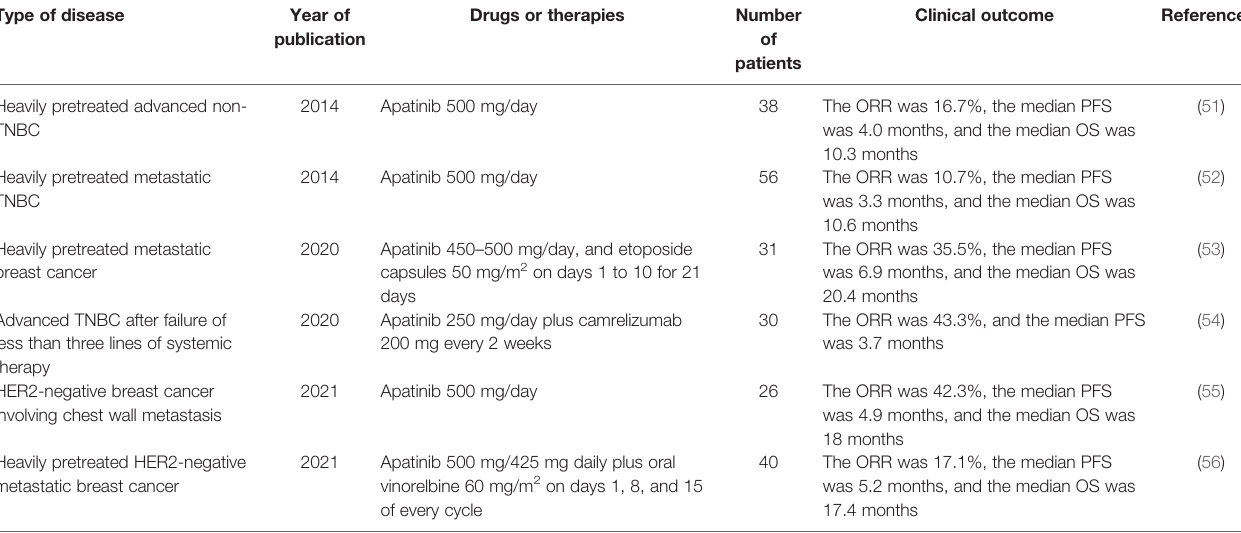
TABLE 5 | Clinical trials on apatinib for breast cancer treatment included in this